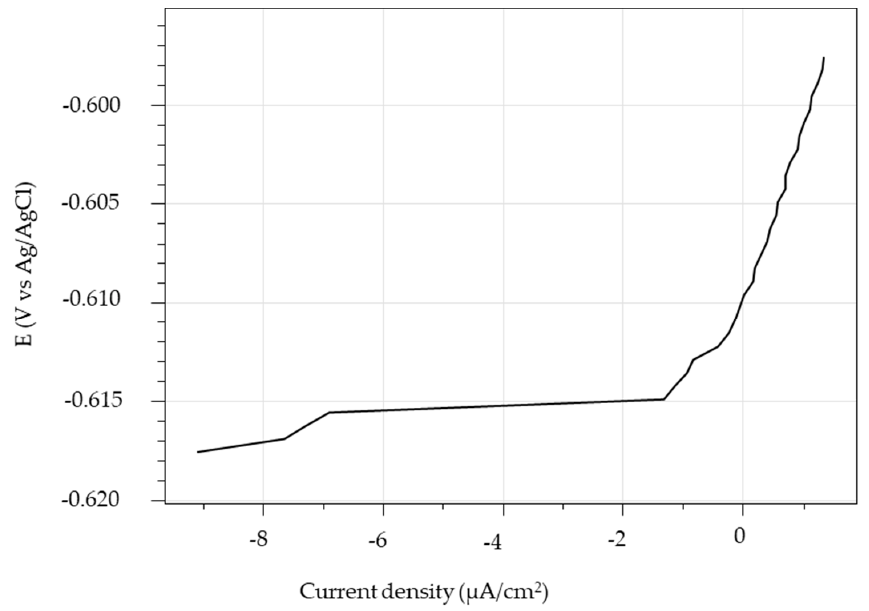
Figure 5. A typical polarization curve for a sample (S10) in SW+bacteria (MIC), exposed for 14 days.